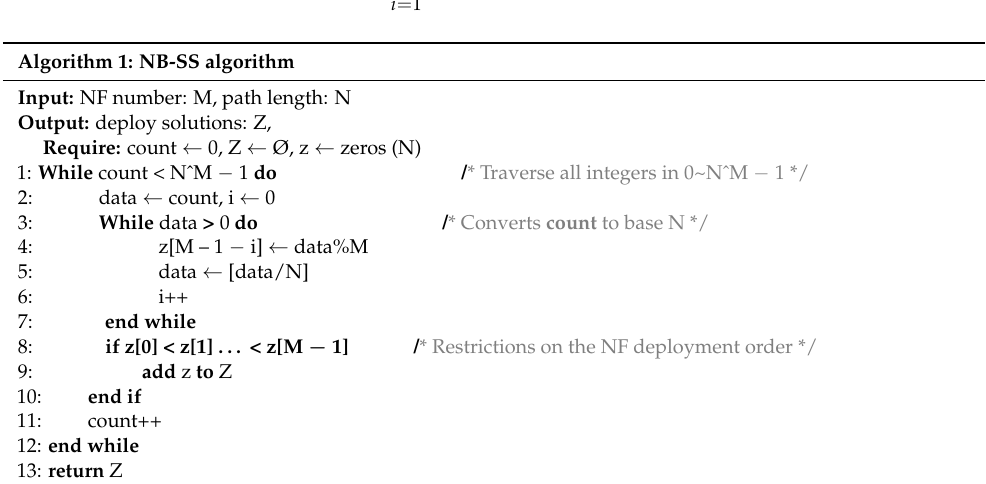
Algorithm 1: NB-SS algorithm